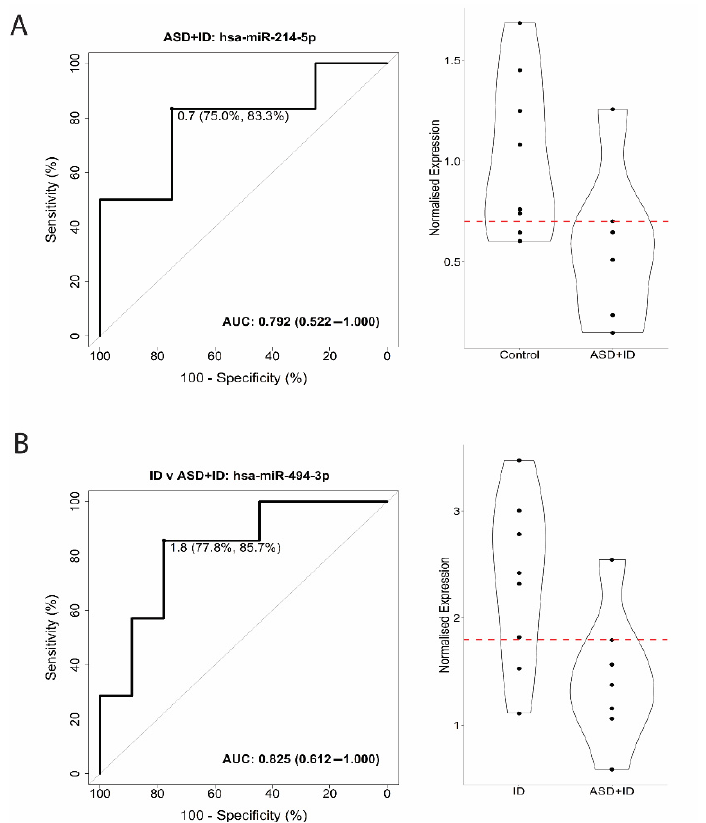
Figure 2. Receiver operating characteristic (ROC) curve analysis and violin plots for PCR validation of Autism Spectrum Disorder + Intellectual Disability (ASD + ID), as well as for discriminating between ID and ASD + ID. ( A ). ROC curve analysis for the miRNAs showed 83.3% sensitivity and 75.0% specificity for hsa-miR-214-5p in discriminating between controls (TSC without TANDs) and ASD + ID, corresponding to an AUC of 0.792. ( B ). For the discrimination between ID and ASD + ID, hsa-miR-494-3p showed an 85.7% sensitivity and 77.8% specificity, corresponding to an AUC of 0.825. X-axis ROC curve: 100-Specificity in percentage (%); Y-axis ROC curve: Sensitivity in percentage (%); X-axis violin plot: Groups; Y-axis violin plot: Normalized expression. The red dotted line in each violin plot indicates the threshold that optimizes group separation.